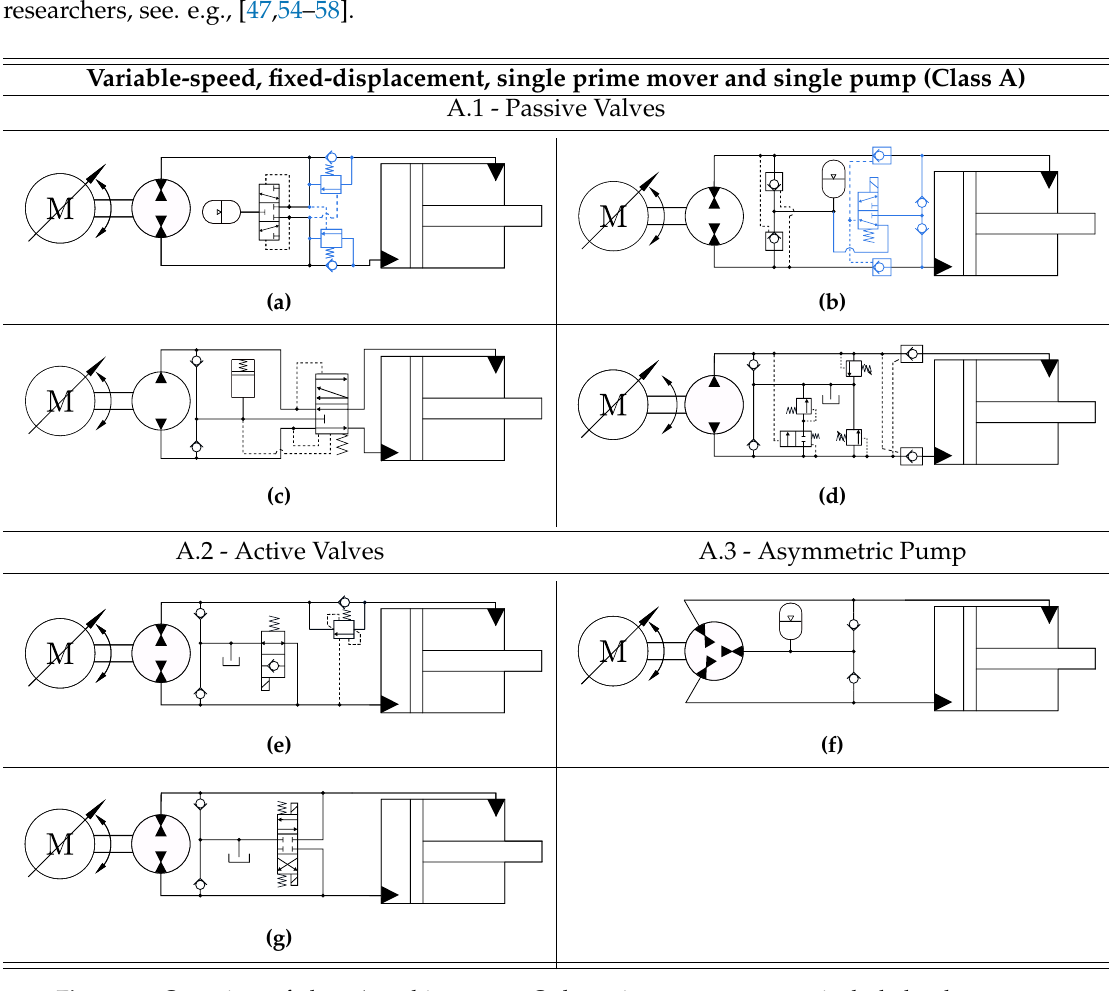
Figure 5. Overview of class A architectures. Only main components are included, whereas e.g., anti-cavitation and pressure-relief valves are omitted for simplicity. Blue components indicate that these components are only included by some researchers. ( a ) Architecture based on an inverse shuttle valve; ( b ) Architecture based on pilot-operated check valves; ( c ) Architecture based on a passively actuated directional valve; ( d ) EHA concept by Parker Hannifin; ( e ) Architecture based on actively controlled on/off valve; ( f ) Architecture based on asymmetric pump; ( g ) Architecture based on actively controlled directional